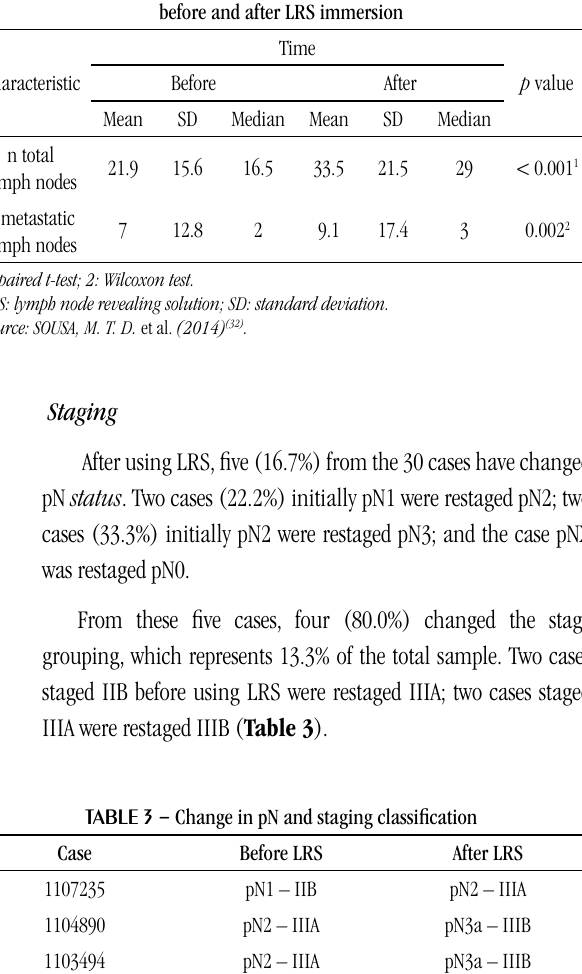
tABLE 2 − Average number of lymph nodes and metastatic lymph nodes before and after LRS immersion